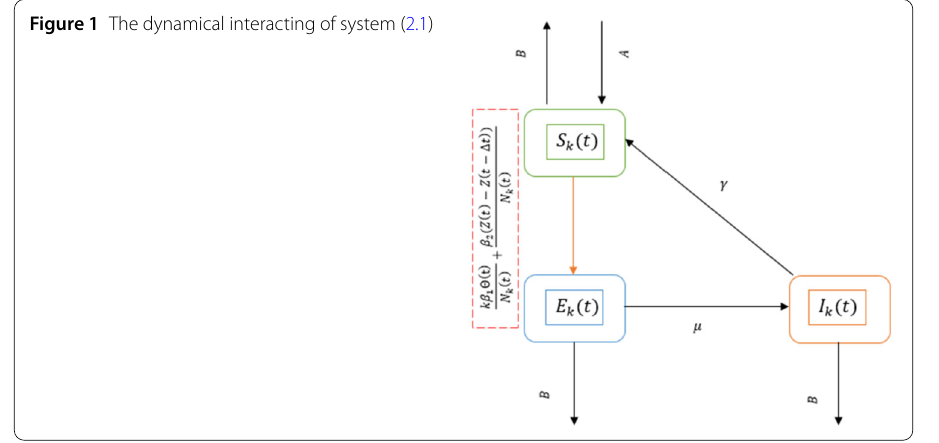
Figure 1 The dynamical interacting of system